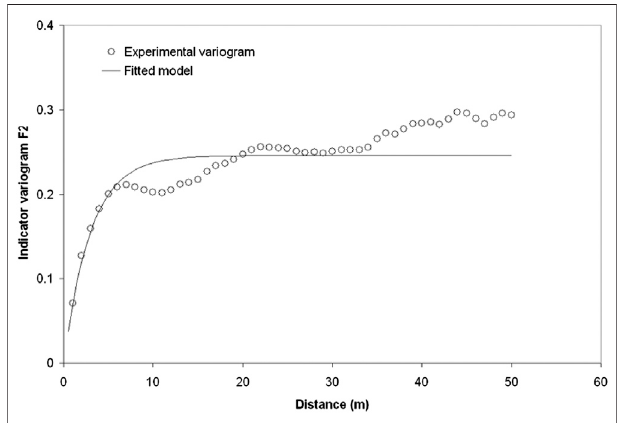
FIGURE 7 | Indicator variograms for hydrofacies F2 and fi tted model.